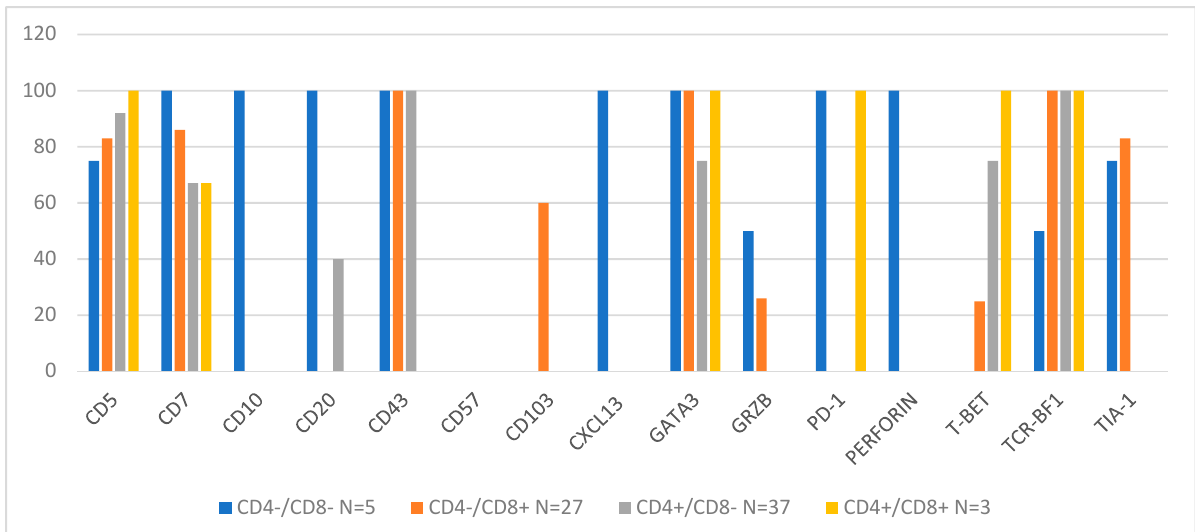
Figure 2. Immunoprofile of the 4 groups of iTLPD-GIs, stratified according to their coordinate CD4/CD8 expression.